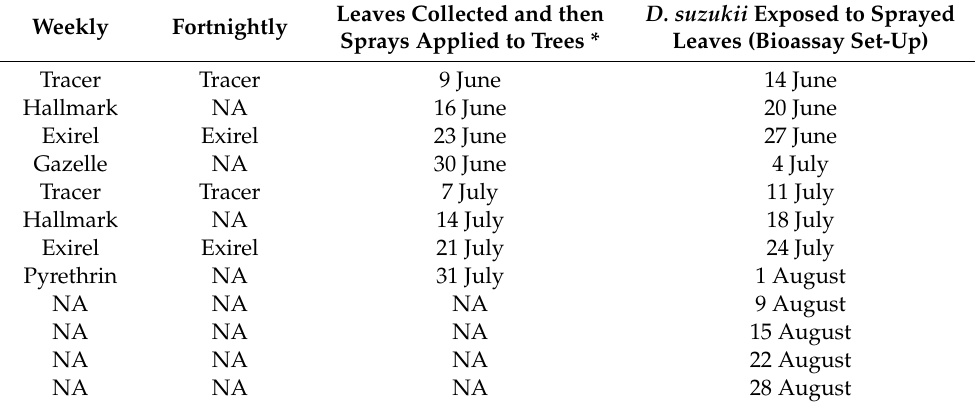
Table 2. Timing of leaf collection and spray program applied to cv. Penny cherry experimental orchard trees and the dates the leaf samples were collected for the laboratory D. suzukii adult mortality bioassays. Leaves were sampled from all plots just before the next spray was applied. * Always applied on the weekly program, but only every two weeks in the fortnightly program (NA = not applicable).